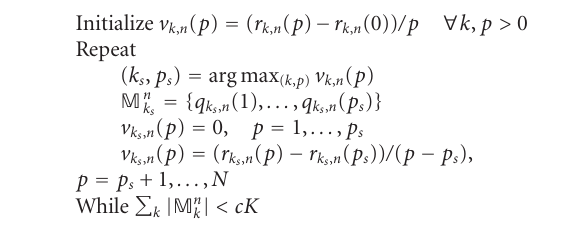
Algorithm 4: Optimal tone-line